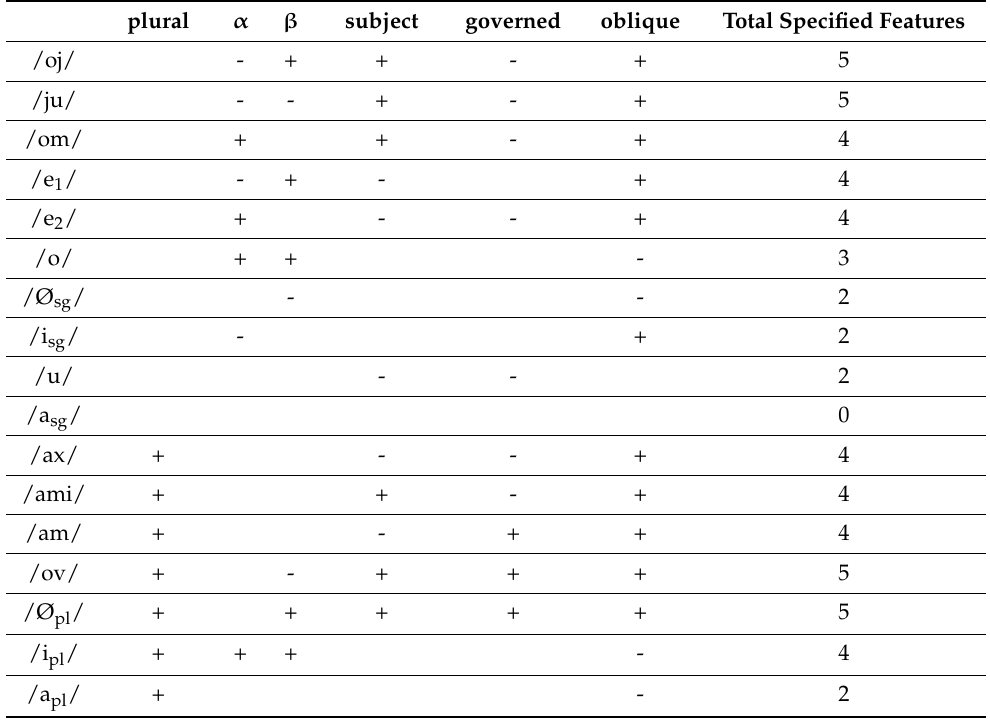
Table 4. Russian inflectional affix features according to Müller